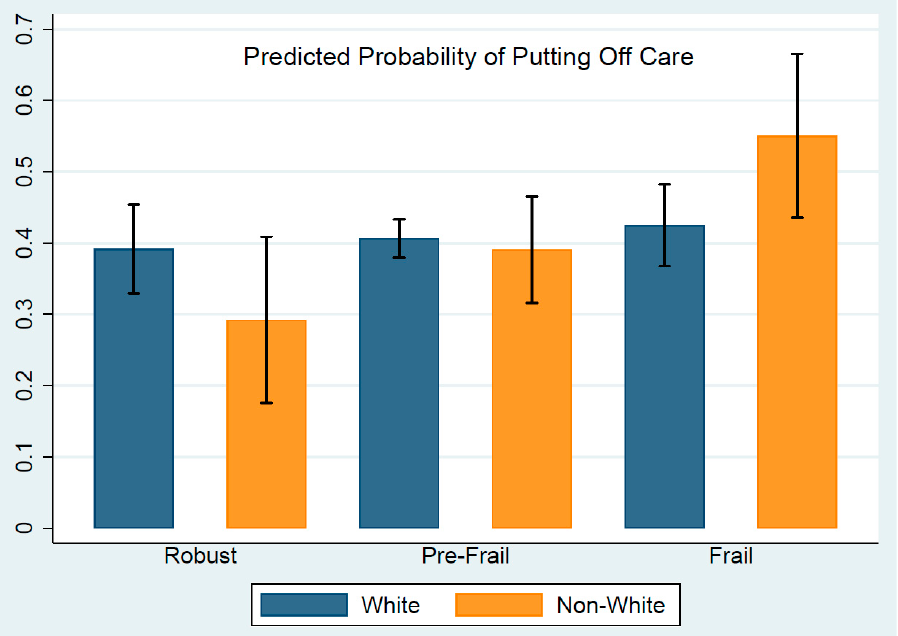
Figure 1. Predicted probability of putting off care by frailty and race/ethnicity. Table 4. Reasons for putting off care by frailty and